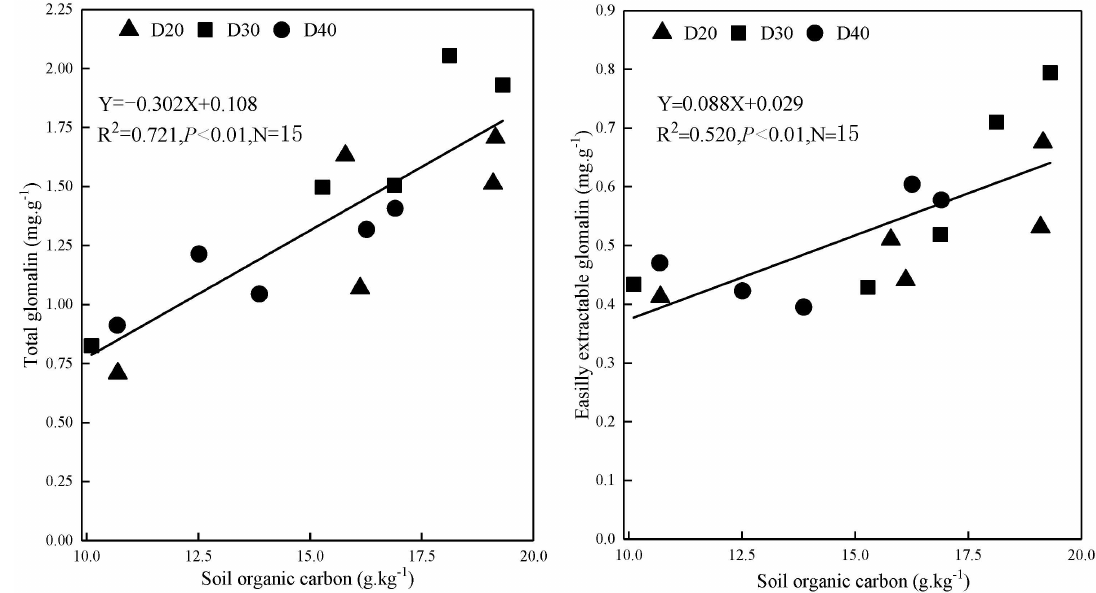
Figure 7. Concentration of SOC in relation to those of T − GRSP or EE −